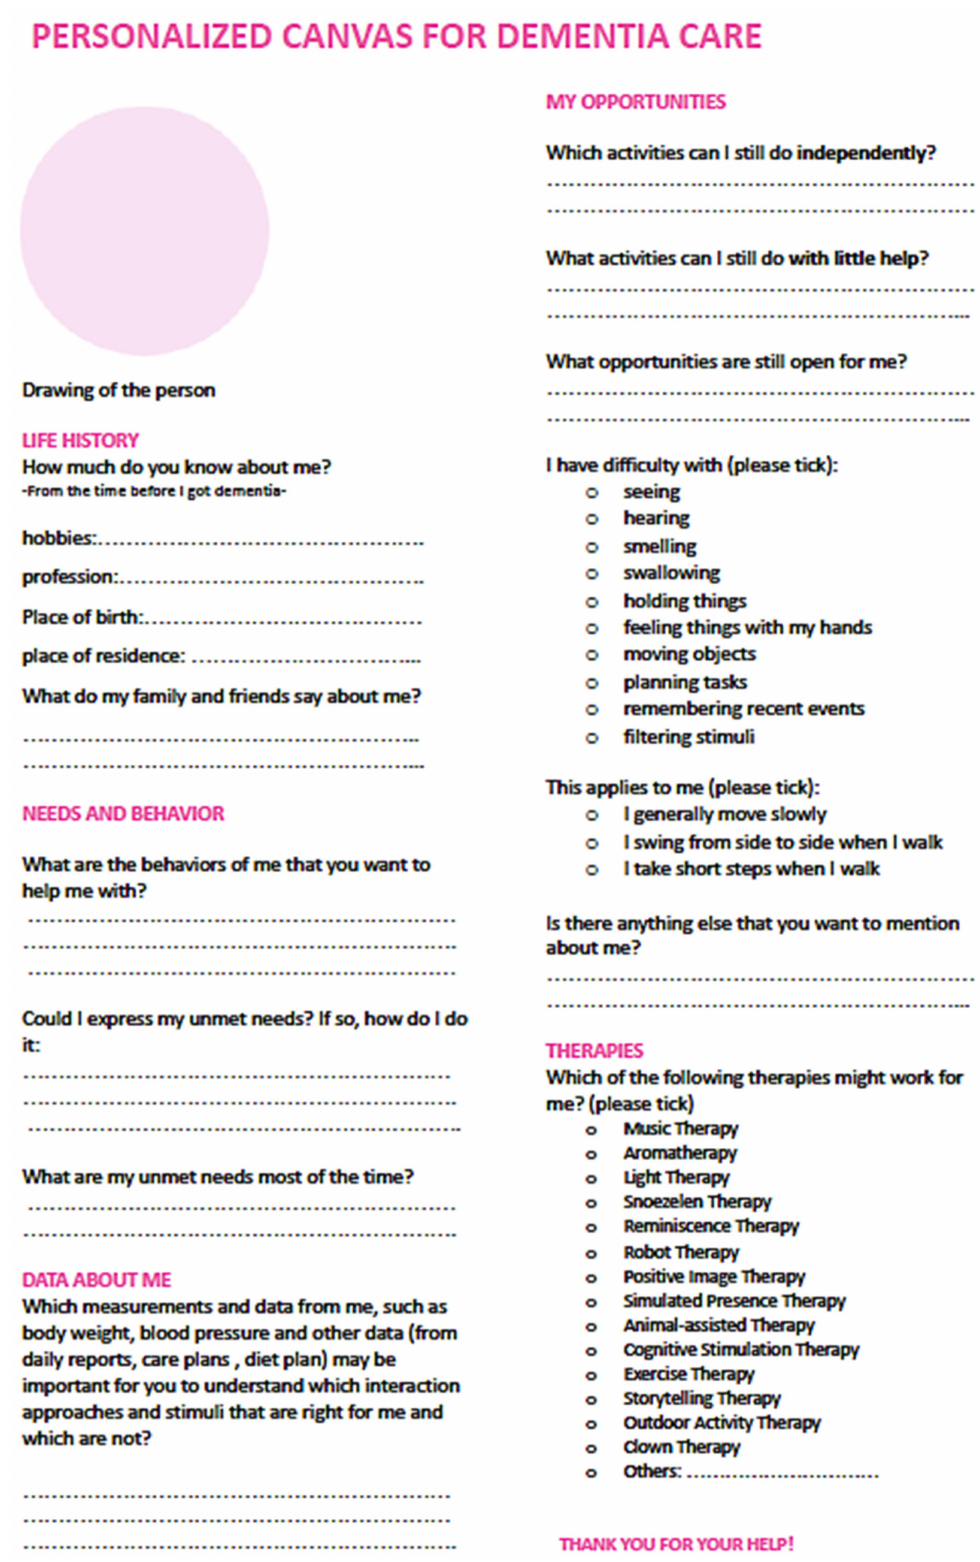
Figure 8. The person-centred canvas template for the care team (translated in